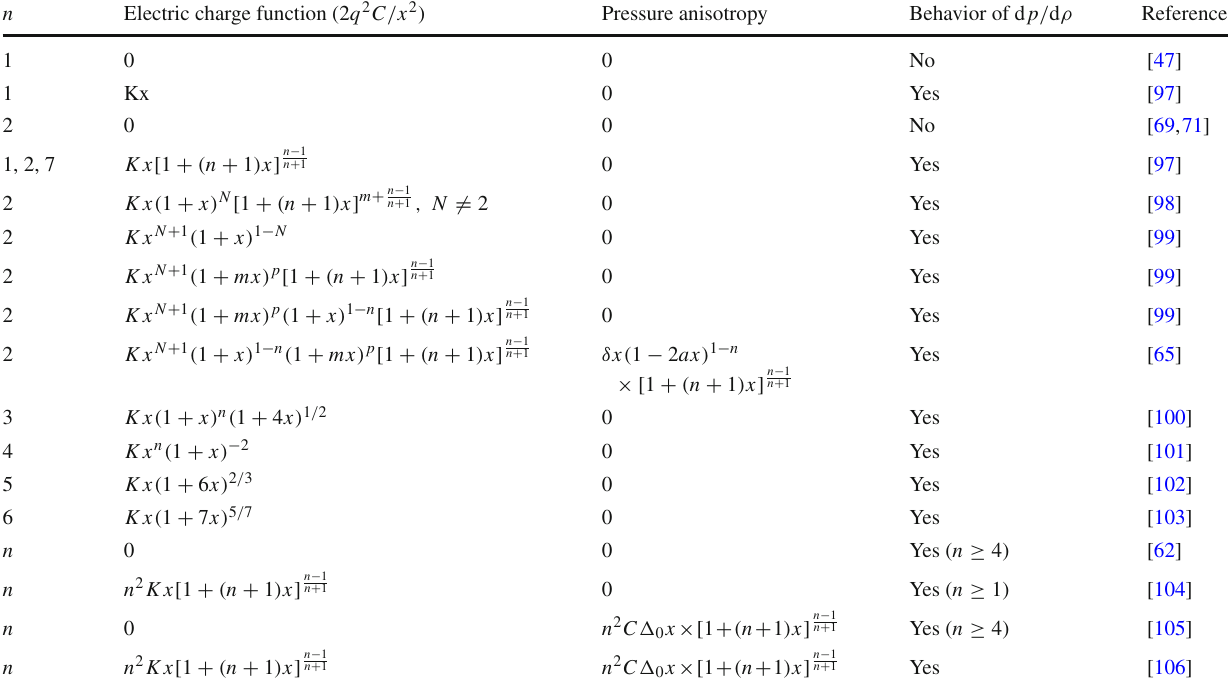
Table 7 List of regular behavior of d p / d ρ for the ansatz e ν( r ) = B ( 1 + x ) n , with x = Cr 2 where p in the table is a positive integer n Electric charge function (2 q 2 C / x 2 )